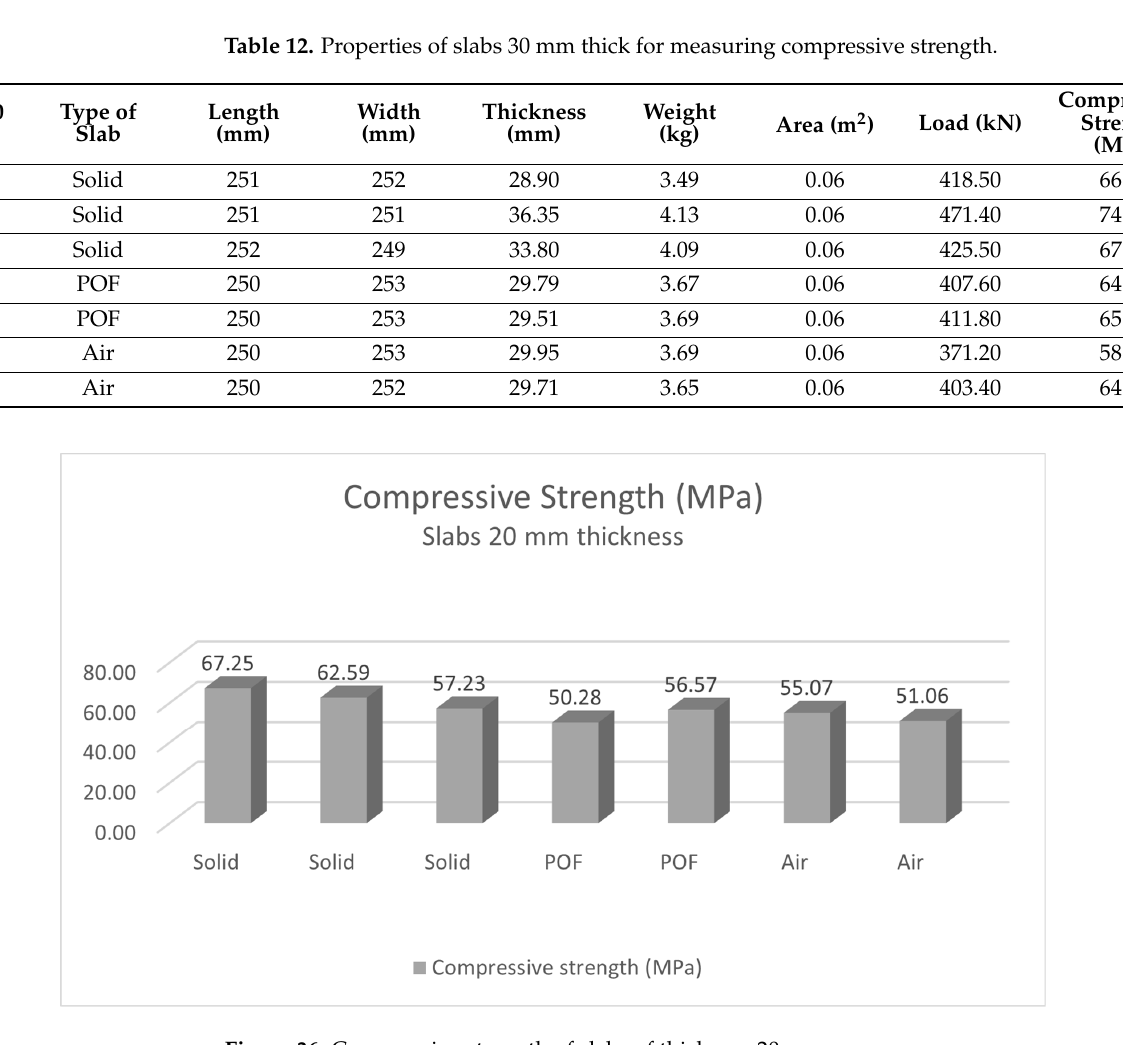
Figure 37. Compressive strength of slabs of thickness 30 mm.